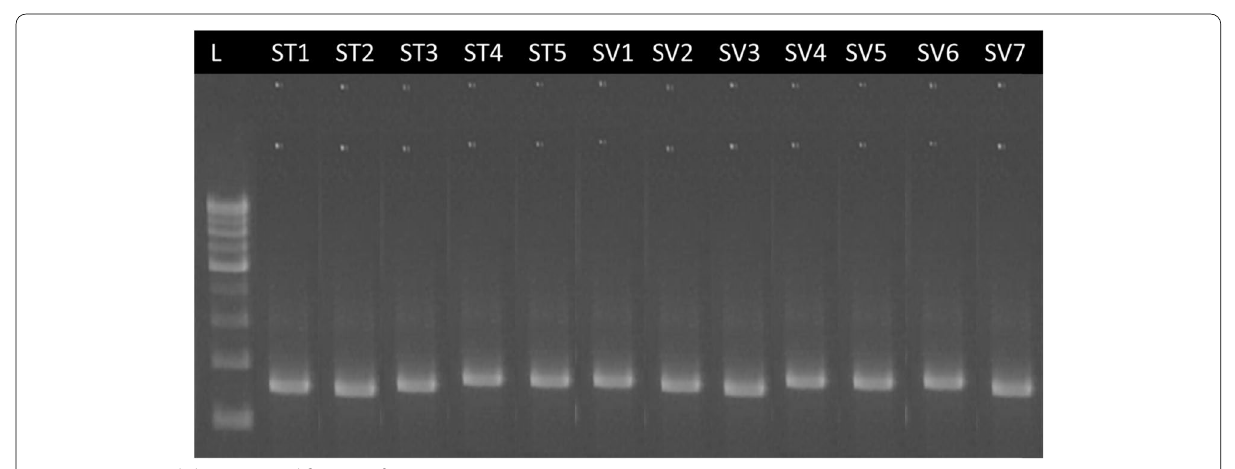
Fig. 2 Agarose gel showing amplification of matK